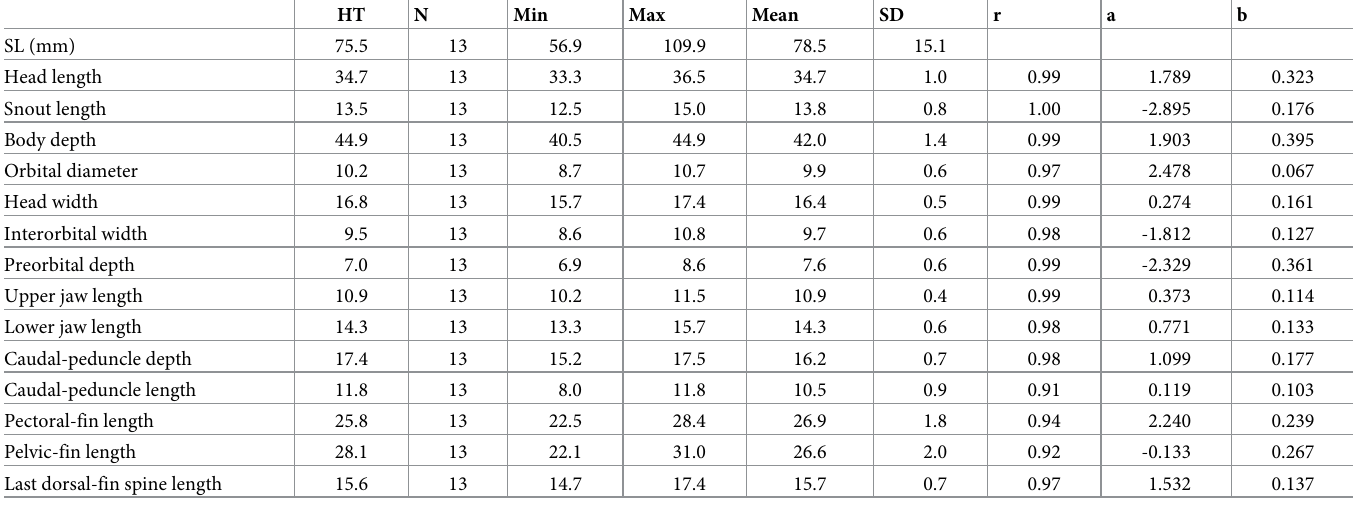
Table 18. Australoheros ricani . Size (SL), proportional measurements (per cent of SL) and linear regression parameters. HT N